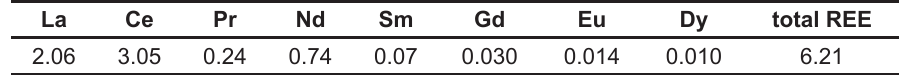
Table 2. The content of the rare earth elements in the ore, wt.%